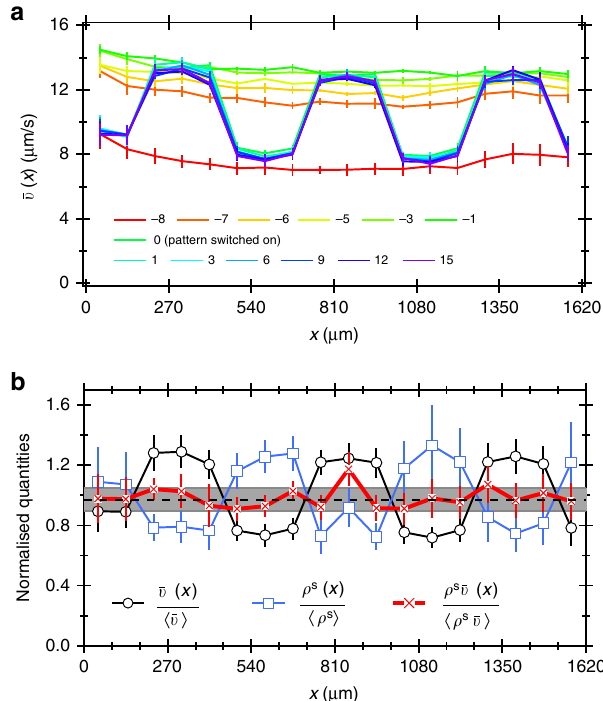
Fig. 5 Response of bacteria to the imposition of a 1D square wave with 270 μ m wide stripes. a The evolution of the speed pro fi le normalised to its (time) average, with time increasing from red to violet (legend gives t in minutes): initially illumination is uniform, with the intensity getting increased from low to high at t = − 7 min, then the pattern is applied at t = 0 for 15 min. b The spatial pro fi les of various normalised quantities as indicated in the legend after 15 min of patterned illumination. Error bars represent s.d. Dashed line (and grey area) is the average (±1 s.d.) over all tiles for the uniform case ( t < 0). Error bars show propagated